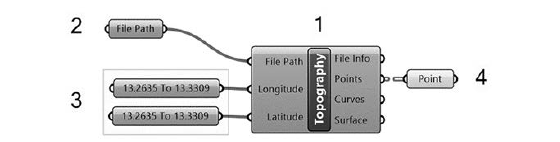
Figure 1. Instructions of the macro to process GeoTiff